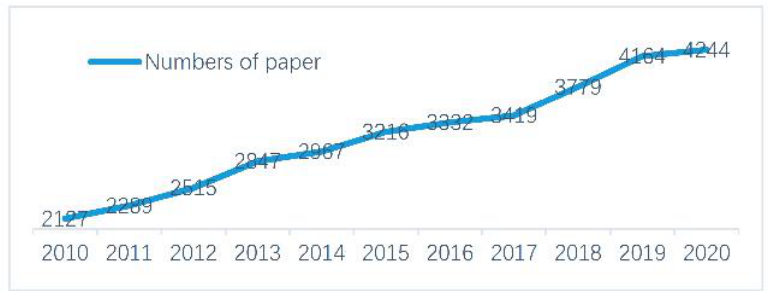
Figure 1. Papers regarding accidental falls in older adults (2010–2020).